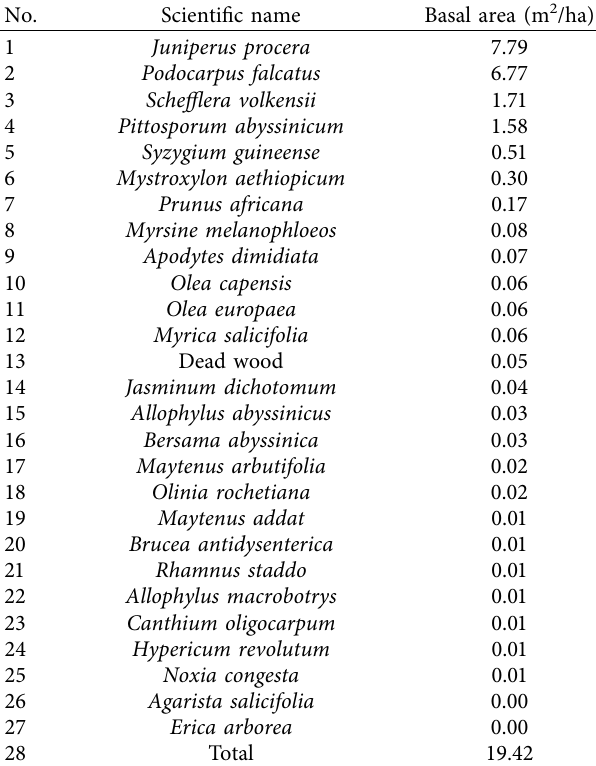
Table 4: Showing basal area of woody species in the Gennemar forest.